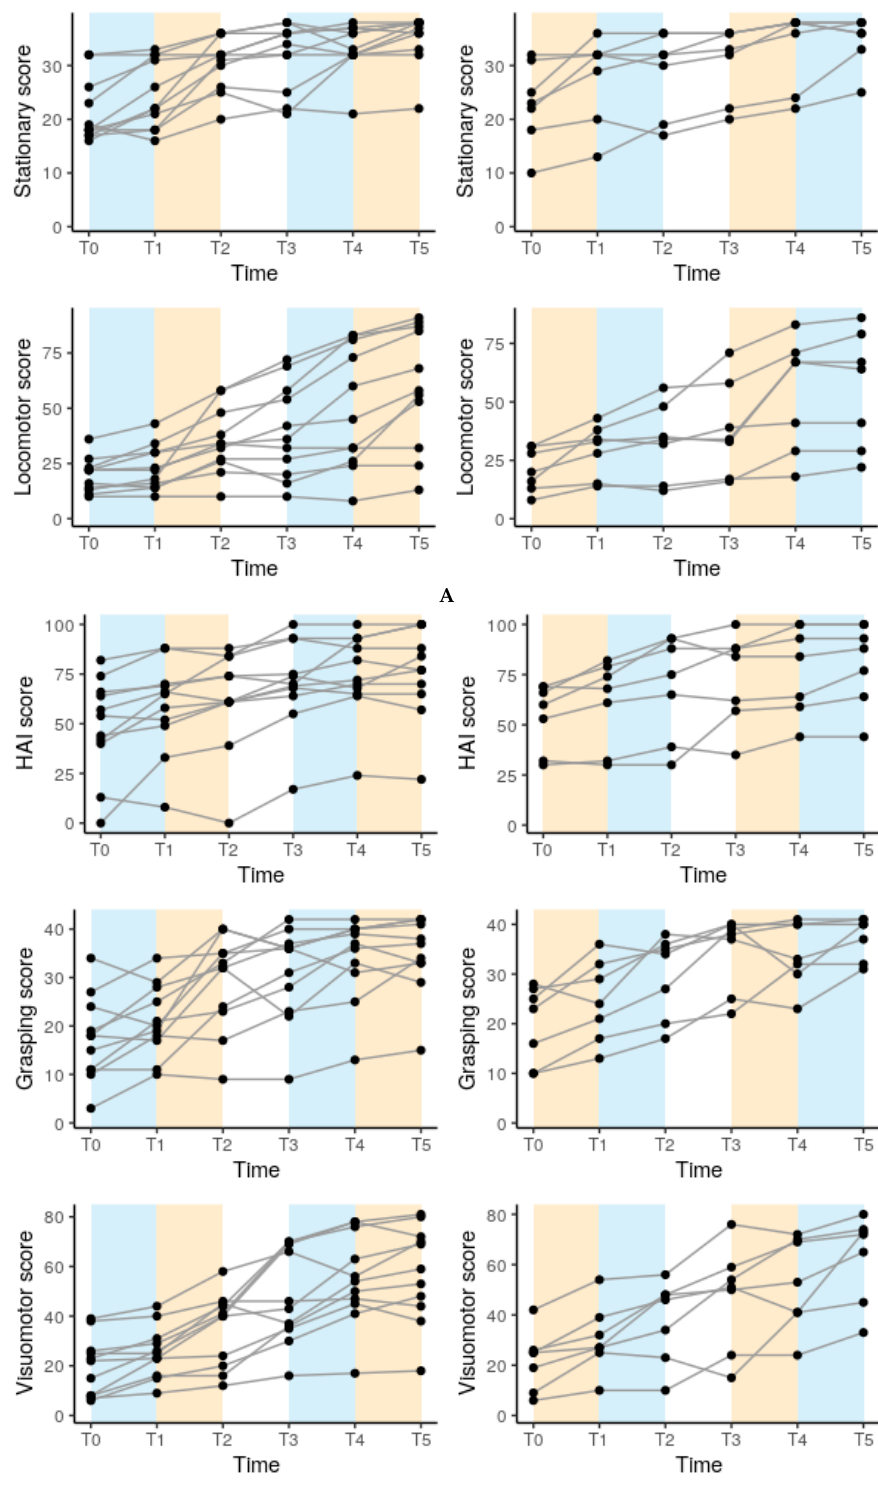
Figure 2. Individual trajectories of the different outcomes over the course of the intervention. Hand use periods are indicated in blue, mobility training periods in orange, and intermission of motor training in white. The plots on the left show the trajectories of infants that started with hand use training, and the plots on the right show the trajectories of those who started with mobility training. ( A ) Infants starting with mobility training. ( B ) Infants starting with hand use training. For further clarification of the time points T0–T5, see Figure 1.